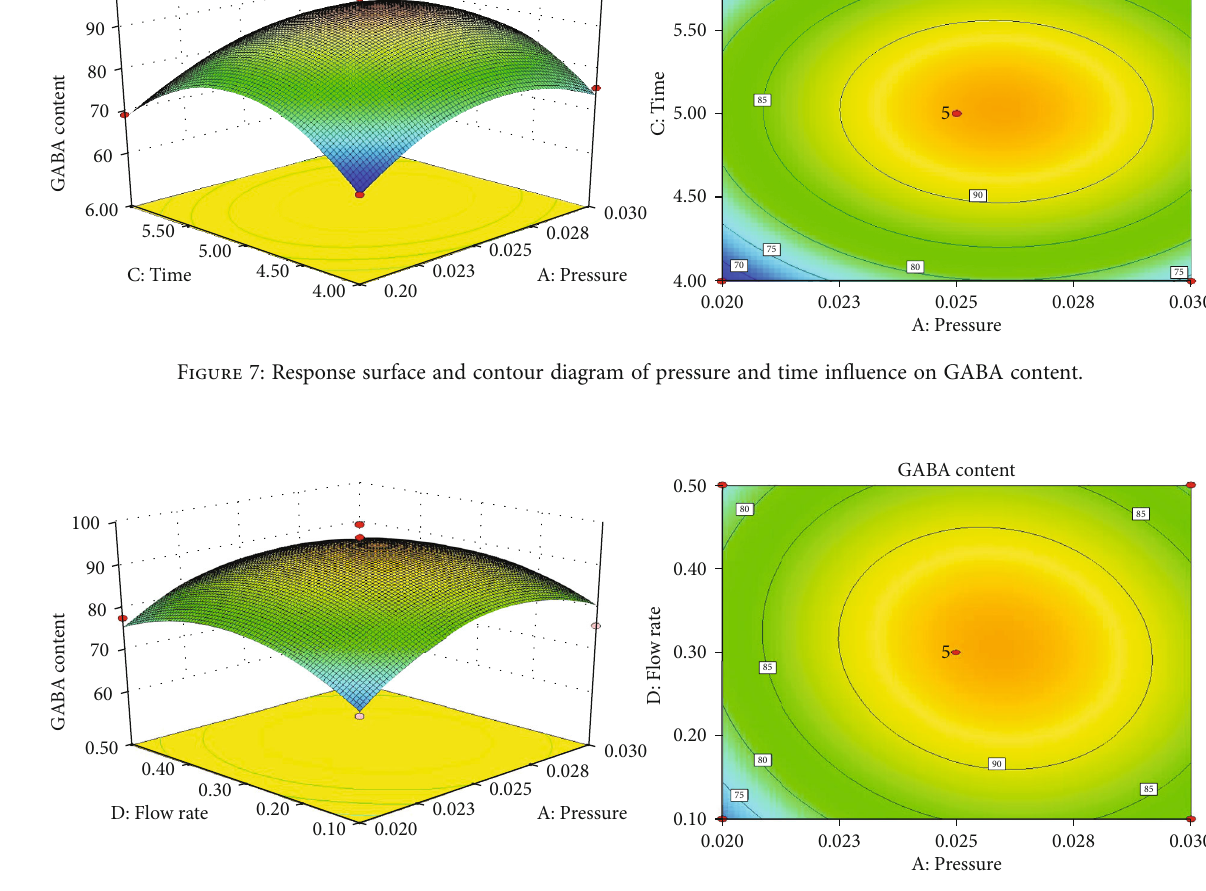
Figure 8: Response surface and contour diagram of pressure and fl ow rate in fl uence on GABA